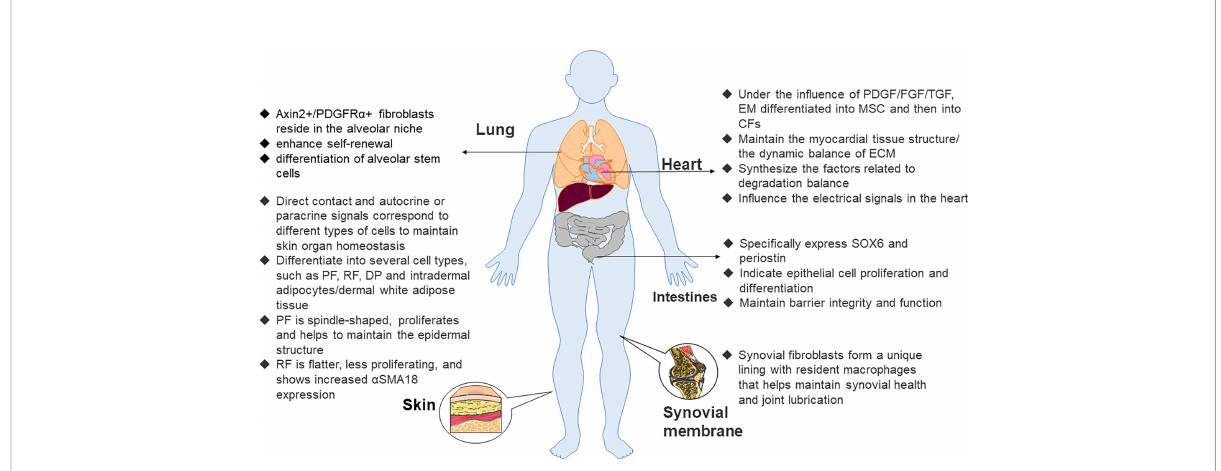
FIGURE 1 Functions of fi broblasts in various organs. Axin2, axis inhibition protein 2, PDGFR a , platelet – derived growth factor receptor a , PF, papillary fi broblast, RF, reticular fi broblast, DP, dermal papilla, a – SMA 18, a – smooth muscle actin 18, PDGF, platelet – derived growth factor, FGF, fi broblast growth factor, EM, epithelial mesenchymal, CF, cardiac fi broblast, MSC, mesenchymal stem cell, ECM, extracellular